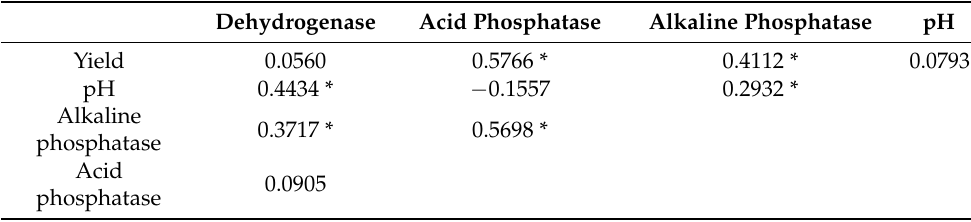
Table 8. The r-Pearson correlation coefficient between the parameters examined. Dehydrogenase Acid Phosphatase Alkaline Phosphatase pH Yield 0.0560 0.5766 * 0.4112 * 0.0793 pH 0.4434 * − 0.1557 0.2932 * Alkaline 0.3717 * 0.5698 * phosphatase Acid